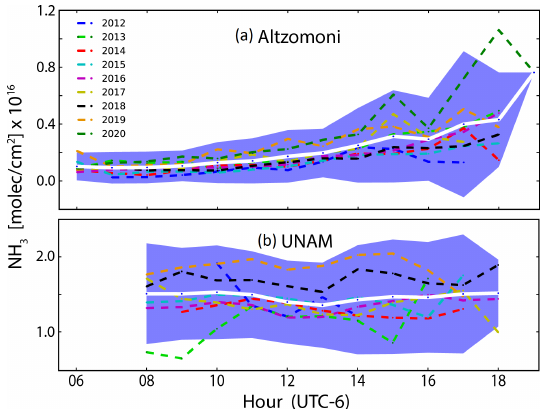
Figure 3. Average diurnal evolution of NH 3 total columns over Mexico City at (a) Altzomoni and (b) UNAM. Different years are shown in different colours, the thick white line is the average for all years, and the blue shading indicates ± 1 σ .